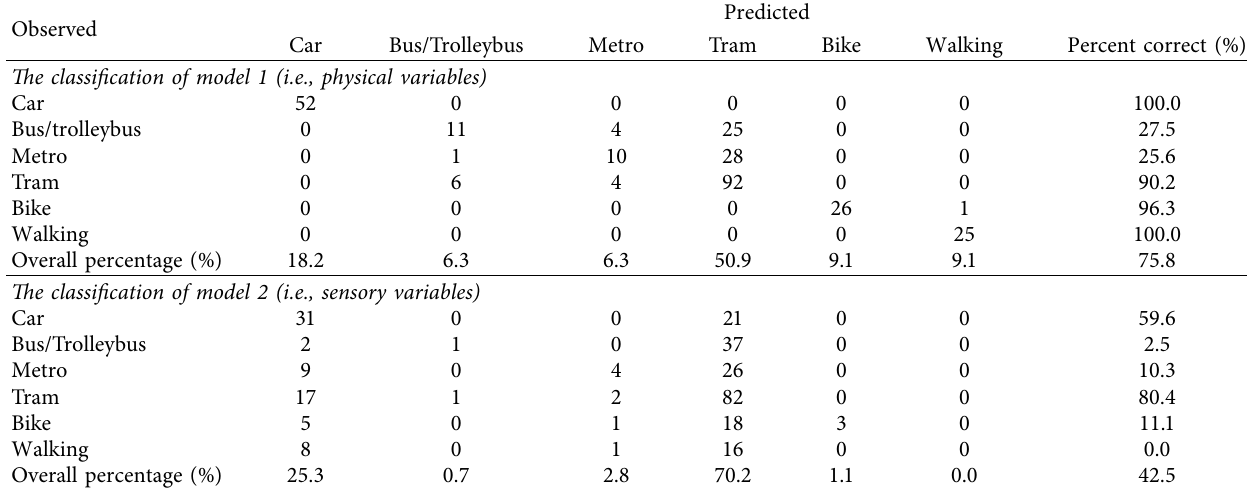
Table 4: The classification of the dependent variable.